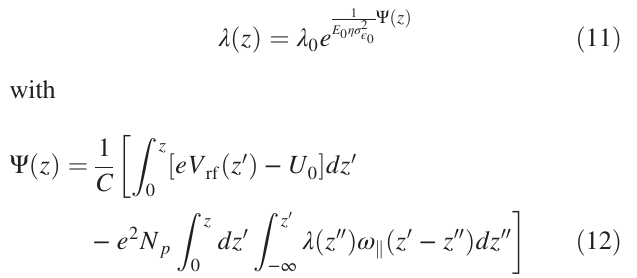
FIG. 5. Longitudinal bunch distribution obtained from Haissinski equation at nominal intensity in the case of no coating and different thicknesses of coating B. The dashed black line represents the Gaussian equilibrium shape. The other machine parameters are those of Table I with the lowest machine energy.